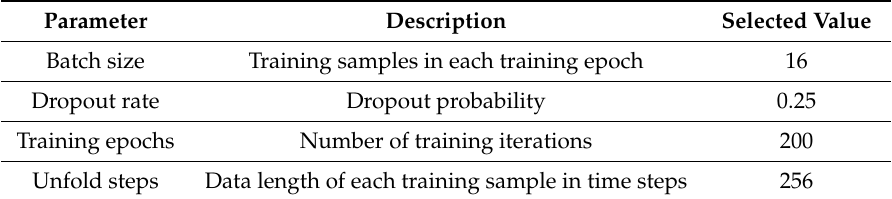
Table 3. Selected parameters.